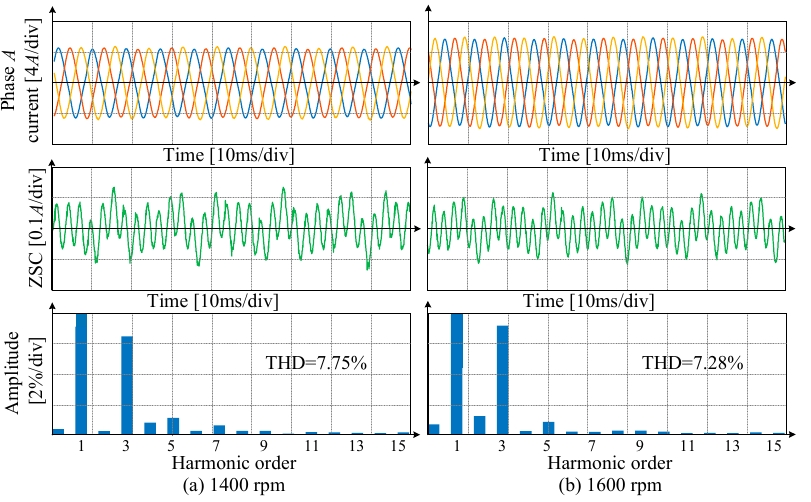
Figure 26. Overmodulation steady-state performance of FW-DFVL under 0.6 Nm ( a ) 1400 rpm situation ( b ) 1600 rpm situation.